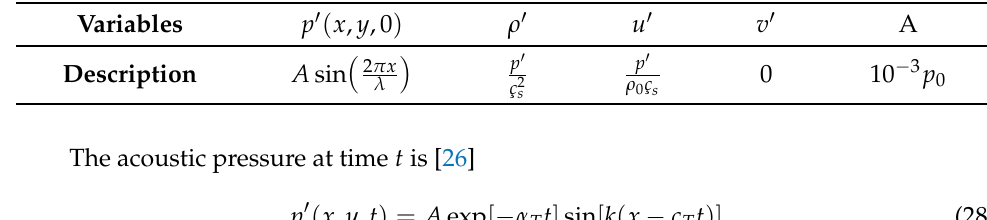
Figure 2. Acoustic pressure ( kg ∆ points per